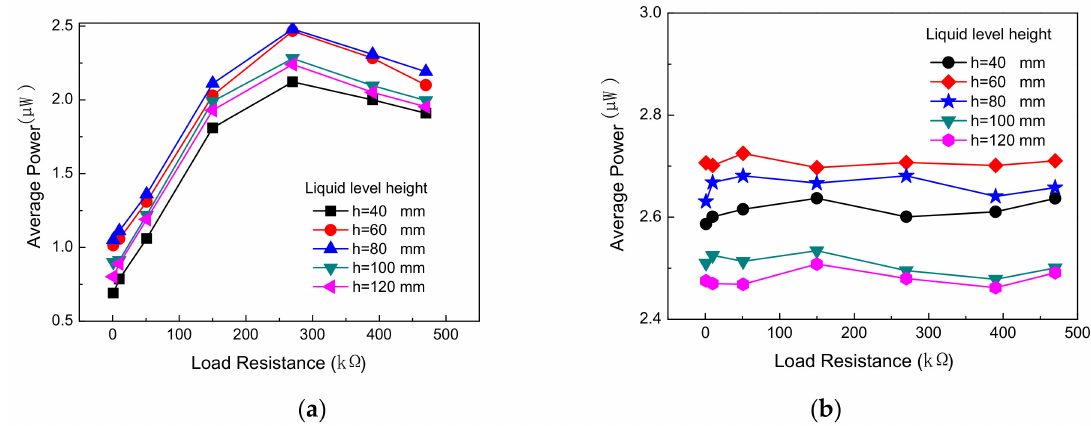
Figure 8. The influence of circuit load on output power of the hybrid energy harvester: ( a ) Piezoelectric transducer; ( b ) Electromagnetic